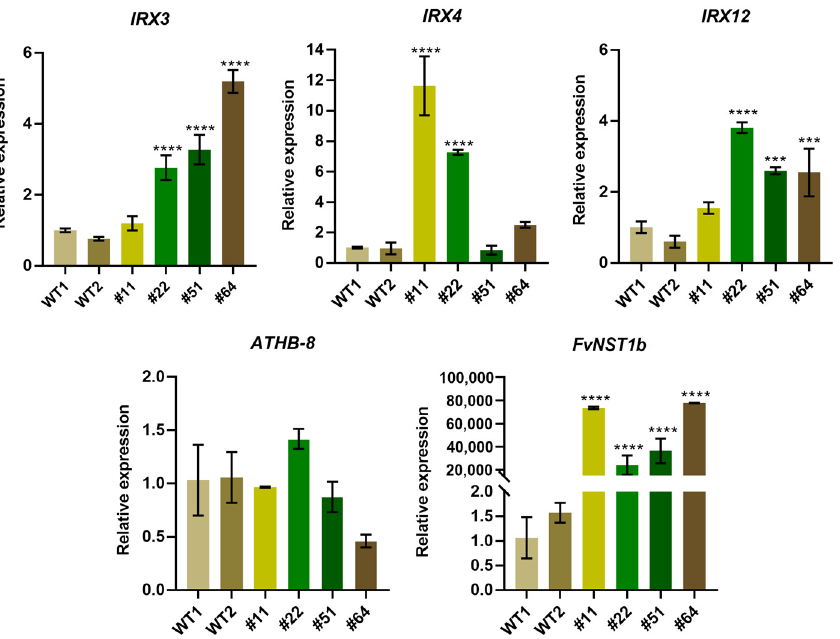
Figure 7. Induction of expression of genes related to the differentiation of tracheary elements in transgenic Arabidopsis plants overexpressing FvNST1b-GFP . Expression of genes related to the differentiation of tracheary elements were analyzed in 2 WT plants as controls and 4 independent transgenic Arabidopsis lines overexpressing FvNST1b-GFP by quantitative RT-PCR. Each bar represents the amount of the transcript of a gene relative to that of the internal control. Error bars represent ± SD (n = 3). Asterisk indicate a significant difference compared to the WT1 by t -test (****, p < 0.0001; ***, p < 0.001).